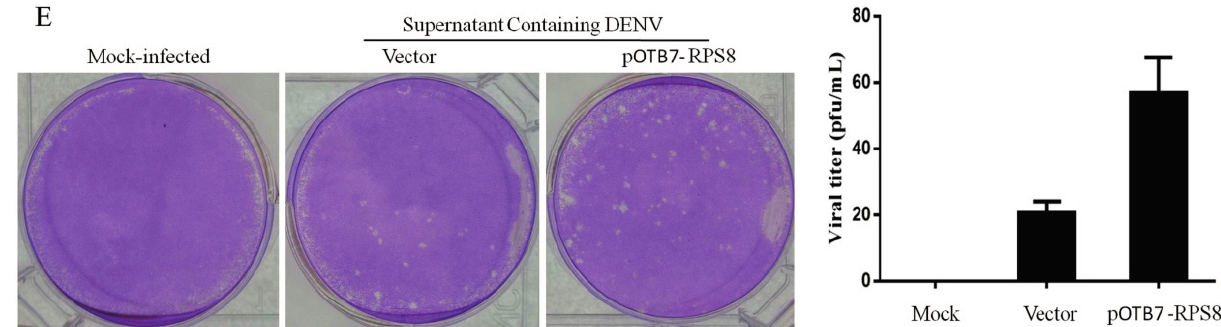
Figure 3. The newly identified 5 ′ –3 ′ UTR RNP candidate RPS8 involved in DENV RNA replication. ( A ) Proteins in input whole cell extract or bound to washed streptavidin beads of 5 ′ –3 ′ U-S1 or mock affinity purifications were used for immunoblot with the antibody against RPS8; ( B ) Viral RNA was co-immunoprecipitated from DENV-infected 293T cell extracts using an anti-RPS8 antibody. Rabbit IgG was used as a negative control. RNA was extracted from the immunoprecipitated complex or from an aliquot of the input lysate and subjected to RT-PCR using DENV 5 ′ UTR primers. The protein RPS8 immunoprecipitated by anti-RPS8 Ab was determined by Western blot; ( C ) RPS8 intracellular localization in mock-infected and DENV-2 infected A549 cells. Cells were fixed at 36 h post-infection and were stained with the nuclear (blue) stain DAPI, with anti-dsRNA (red) and anti-RPS8 (green) antibodies. The merge panel shows an overlay of the DAPI, dsRNA and RPS8 signals; scale bar = 20 μ m; ( D ) RPS8 protein levels in control cells and RPS8 over-expression cells, and the corresponding DENV RNA level in cells was determined by RT-qPCR with primers of DENV 5 ′ UTR; ( E ) The plaque assay result of infectious viral particles yield in culture supernatant from DENV infected control cells and RPS8 over-expressing